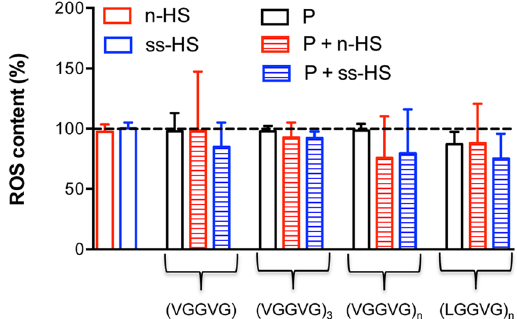
Figure 4. Intracellular content of reactive oxygen species (ROS) evaluated by flow cytometry. The fluorescent probes H 2 DCF-DA and DH 2 were used to detect hydrogen peroxide (H 2 O 2 ) and superoxide anion (O 2 •− ), respectively. Cells were incubated with natural (n-HS) or semisynthetic (ss-HS) heparan sulfate alone, or with peptides (P) i.e. (VGGVG), (VGGVG) 3 , (VGGVG) n and (LGGVG) n alone or in combination with HSs. Values are expressed as percentage of H 2 O 2 + O 2 •− normalized to ROS content obtained in cells cultured in standard medium (dotted line set at 100). Data are represented as mean values ± SD of three